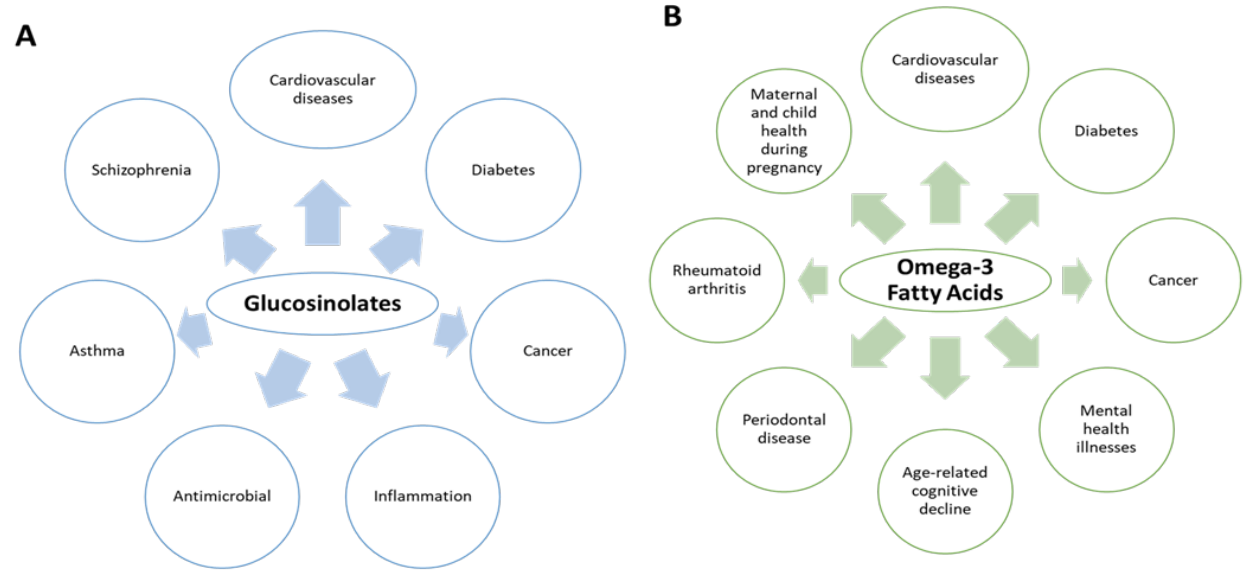
Figure 1. Known human health benefits of glucosinolates ( A ) and omega-3 fatty acids ( B ).